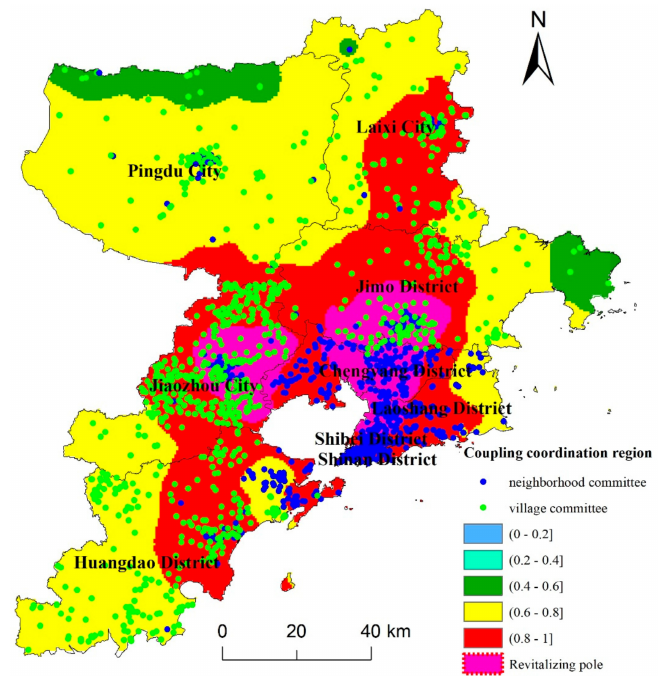
Figure 7. Distribution of coupling coordination zones for rural revitalization in